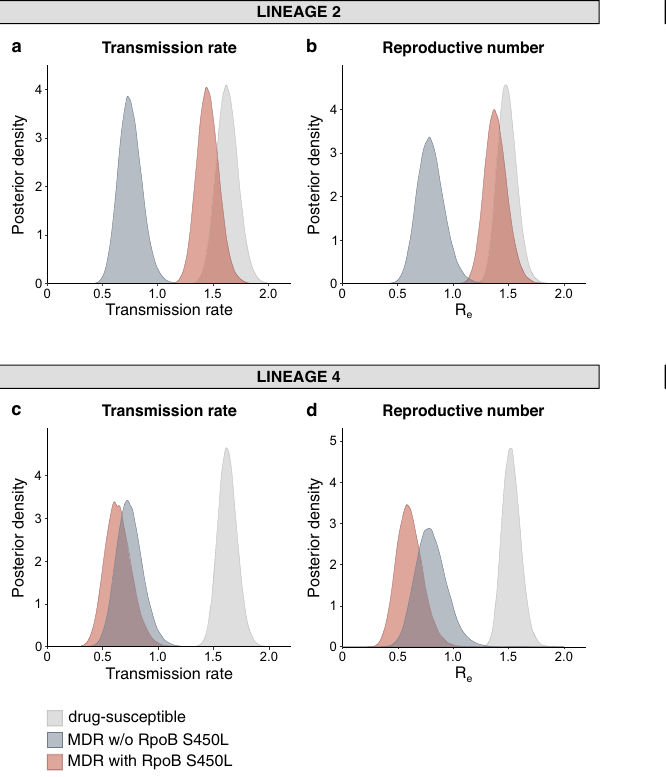
Fig. 4 | The relativetransmission fi tness ofMDR M. tuberculosis by lineage and RpoB mutation. Posterior distributions of the transmission rate and effective reproductive number of drug-susceptible strains, MDR strains carrying the RpoB S450L mutation, and MDR strains carrying other rifampicin resistance-conferring mutations, estimatedby fi ttinga three-type birth-deathmodelona random subset of sequences belonging to L2 ( N =274) ( a , b ) and L4 ( N =228) ( c , d ).